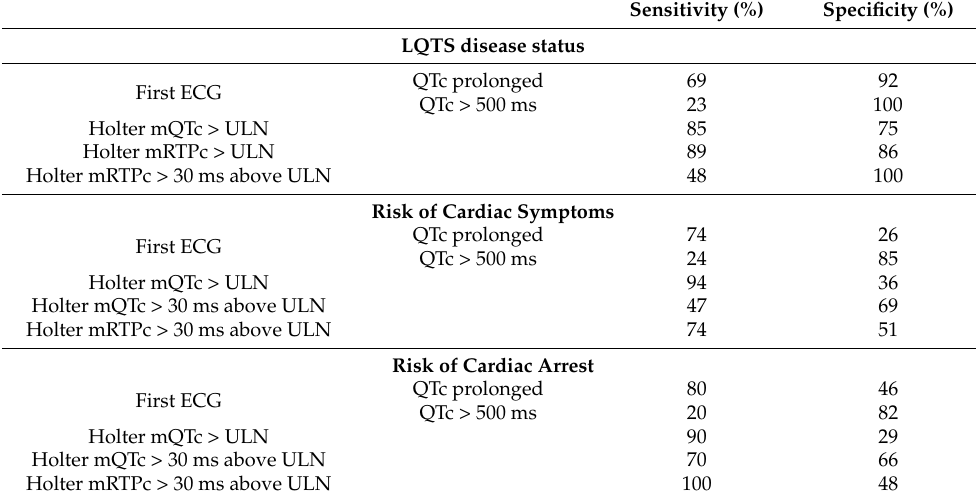
Figure 1. Holter-derived mean QTc (Panel ( A )) and RTPc values (Panel ( B )) from 101 subjects with long QT syndrome, values are mean ± SD (ms, milliseconds). “Girls”—females < 15 years and “Boys”—males < 15 years. Normative ranges are shown in grey shading. The central motif indicates the mean value. Table 3. Comparison of the sensitivity and specificity of initial 12-lead ECG QTc measurements and Holter-derived mQTc and mRTPc for the diagnosis and risk stratification of LQTS among 101 subjects with definite LQTS and 28 family gene-negative